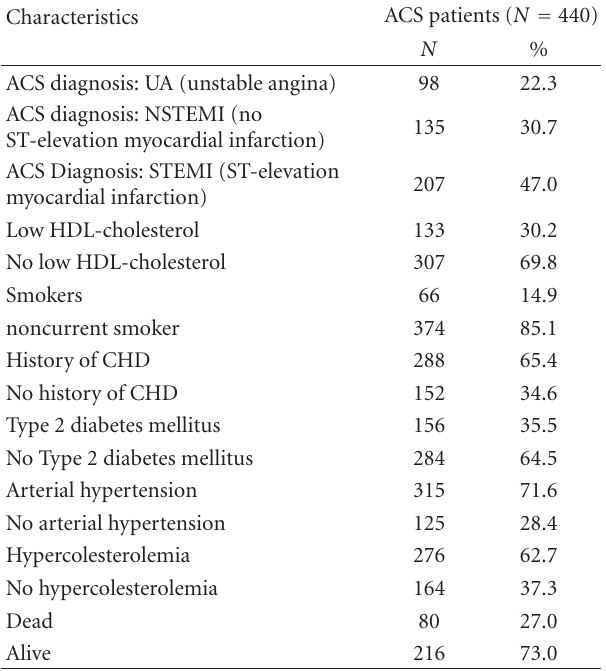
Table 1: Baseline clinical and genetics characteristics of 440 elderly ACS patients.